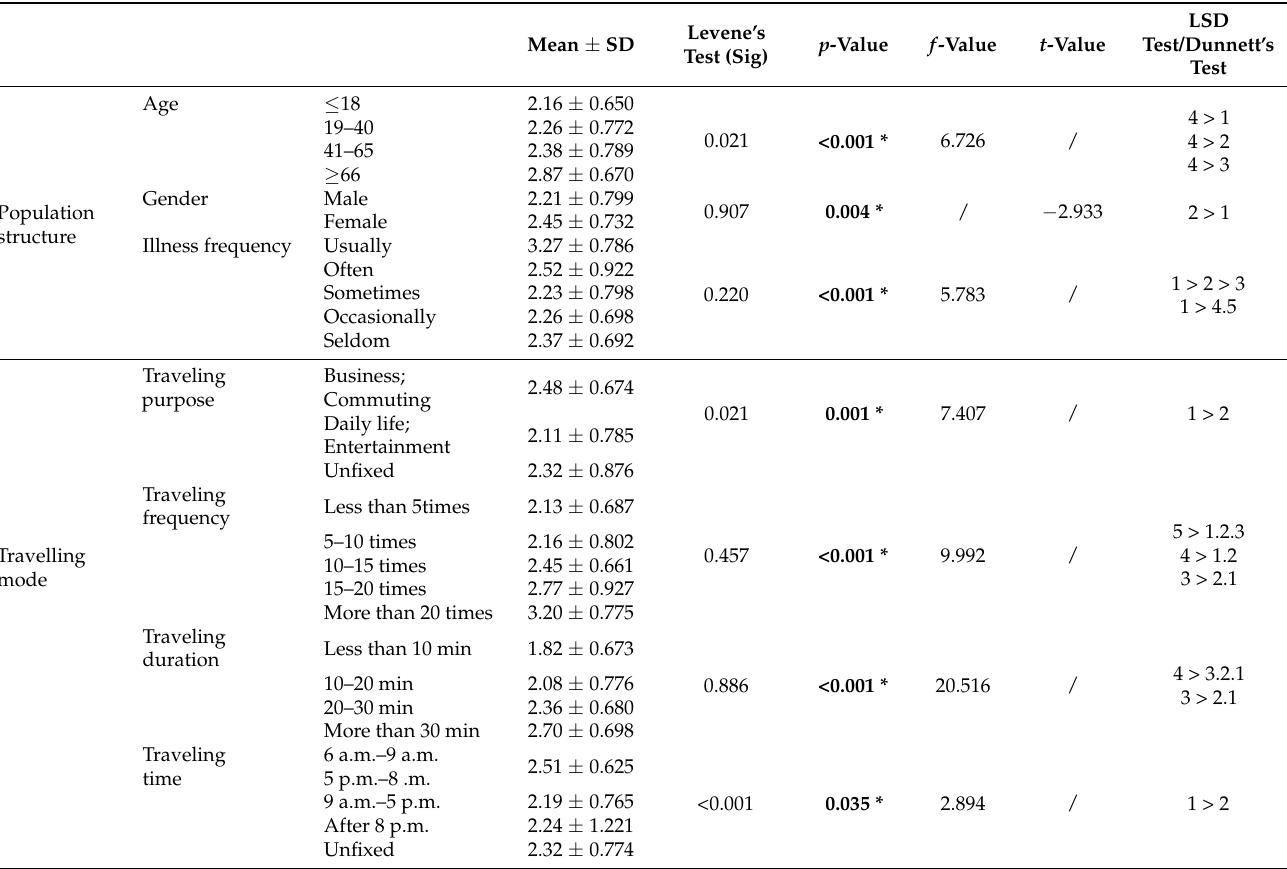
Table 5. Results of the sensitivity